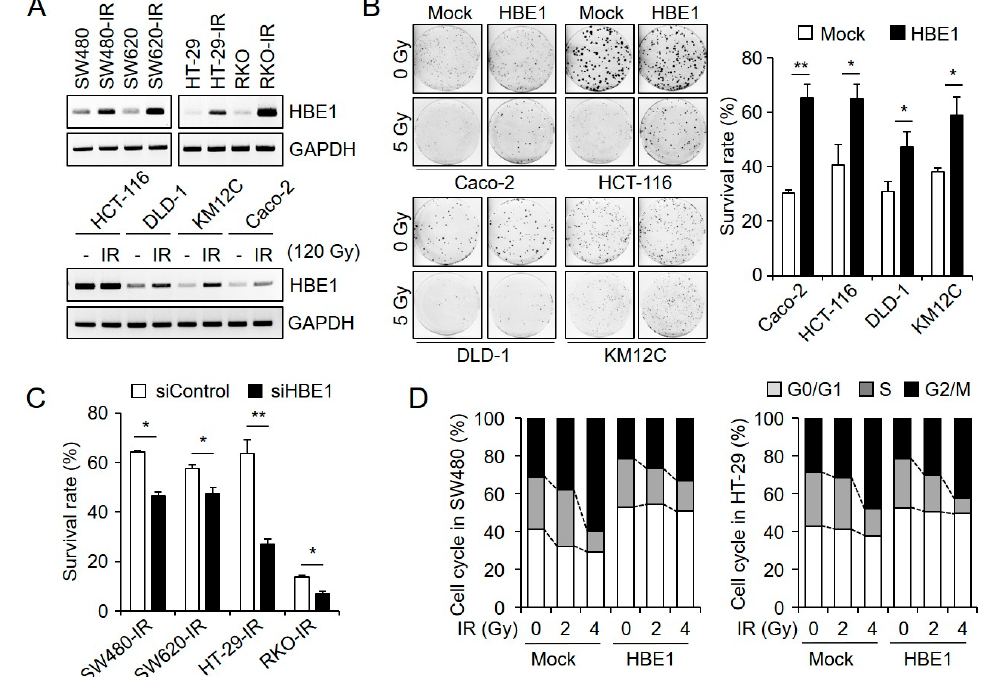
Figure 2. Hemoglobin subunit epsilon 1 (HBE1) expression levels are positively related to radiation resistance in radiation-resistant colorectal cancer cells lines. ( A ) Basal HBE1 mRNA levels in the radiation-resistant cell lines SW480-IR, SW620-IR, HT-29-IR, and RKO-IR cells were significantly up-regulated compared to those in radiosensitive cell lines (SW480, SW620, HT-29, and RKO cells) (upper panel) as determined by RT-PCR. Colorectal cancer cell lines HCT-116, DLD-1, KM12C, and CACO-2 showed transiently increased HBE1 transcriptional levels in response to radiation treatment (120 Gy). (lower panel). ( B ) After transiently transfecting colorectal cancer cells with a mock or HBE1-overexpression vector, cells were analyzed by clonogenic assays. The colony-formation ability of HBE1-overexpressing cells was significantly greater than that in mock cells after irradiation. Representative images are shown in the left panel and a quantitative graph is shown in the right panel. * p < 0.05, ** p < 0.01. ( C ) After transfection with control or HBE1 siRNA in the presence of radiation (5 Gy) exposure, the deficiency in HBE1 decreased the cell survival rate compared to that in control cells, as determined by a clonogenic assay. * p < 0.05, ** p < 0.01. ( D ) HBE1 overexpression in SW480 (left panel) and HT-29 (right panel) cells attenuated G2 / M phase arrest compared to that in mock-treated cells with the indicated levels of irradiation exposure. Graphs present the percentage of cell distribution.